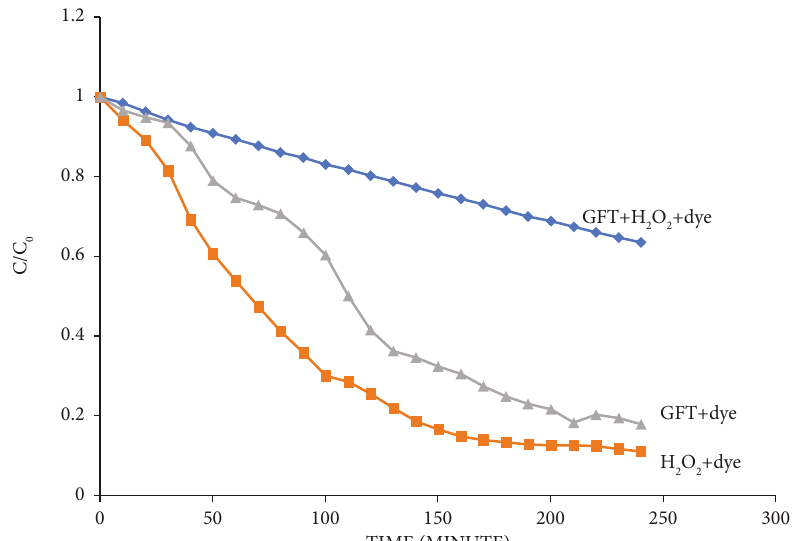
Figure 9: Degradation of AM at di ff erent oxidation conditions (H mg/L, [H O ] = 20mM, [GFT] = 0.2 g/L at pH 8. 2 2